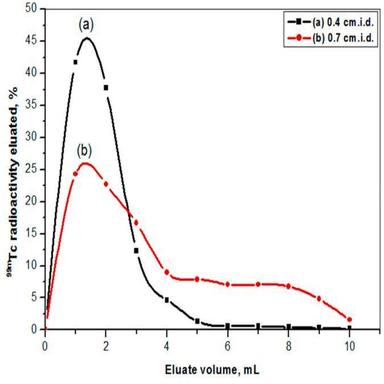
Elution profile of 99mTc obtained from 50 mg mesoporous MnO2/ MWCNT column at different diameter with flow rate 1 ml/min at different diameter.